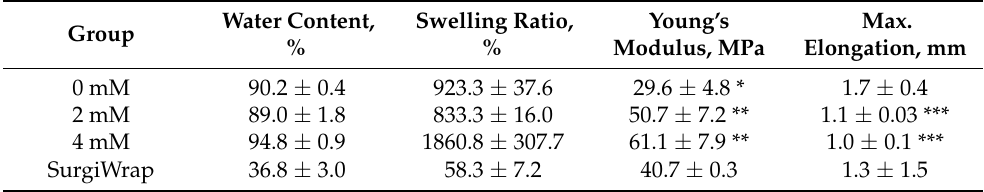
Figure 3. ( A ) Coverage of the GHF and SurgiWrap membranes after RC tear operation; the membranes impregnated with 2 and 4 mM farnesol fit smoothly on the tear sites. SurgiWrap was not malleable, preventing close attachment to the tear site; ( B ) SEM images of the SurgiWrap and GHF membranes before (upper lane, A: SurgiWrap, B: pure GHF membrane, C: 2 mM GHF membrane and D: 4 mM GHF membrane) and after (lower lane, E: SurgiWrap, F: pure GHF membrane, G: 2 mM GHF membrane and H: 4 mM GHF membrane) immersion in PBS solution for 24 h (surface section). RC: rotator cuff; GHF membranes: farnesol-impregnated hydrogel membranes containing hyaluronic acid or gellan gum; PBS: phosphate-buffered saline; SEM: scanning electron microscopy. Magnification: 500 × . Table 2. Characteristics of the hydrogel and SurgiWrap